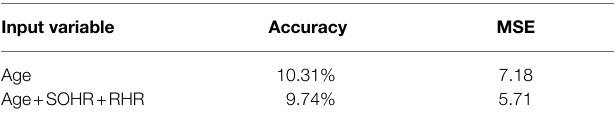
TABLE 2 | Regression models to predict HR max